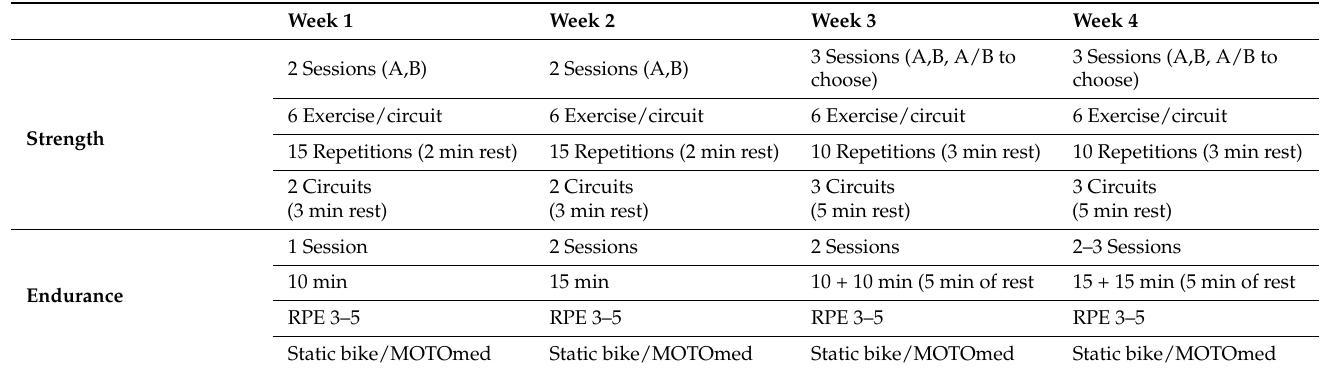
Table 1. Exercise program